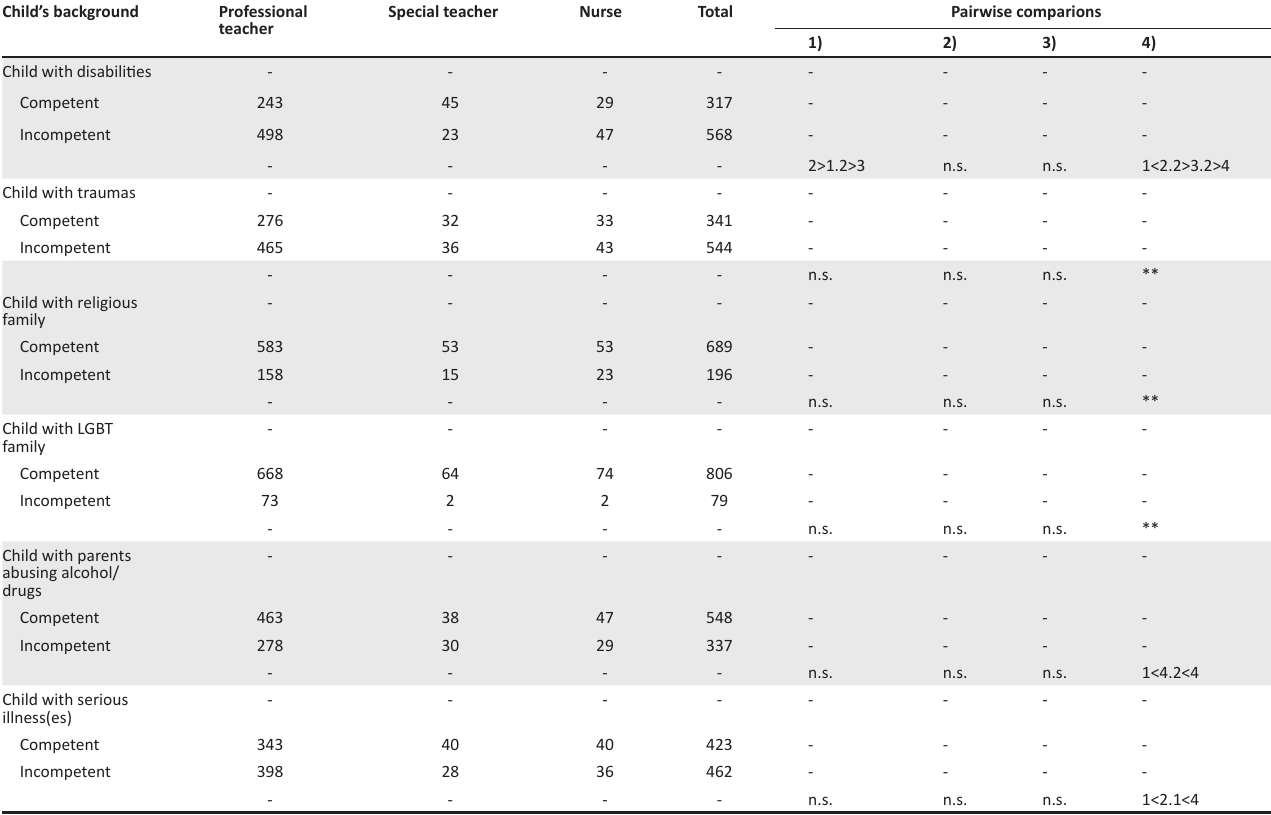
TABLE 3: ECPs’ competence in encountering children with SEN and/or various backgrounds. Child’s